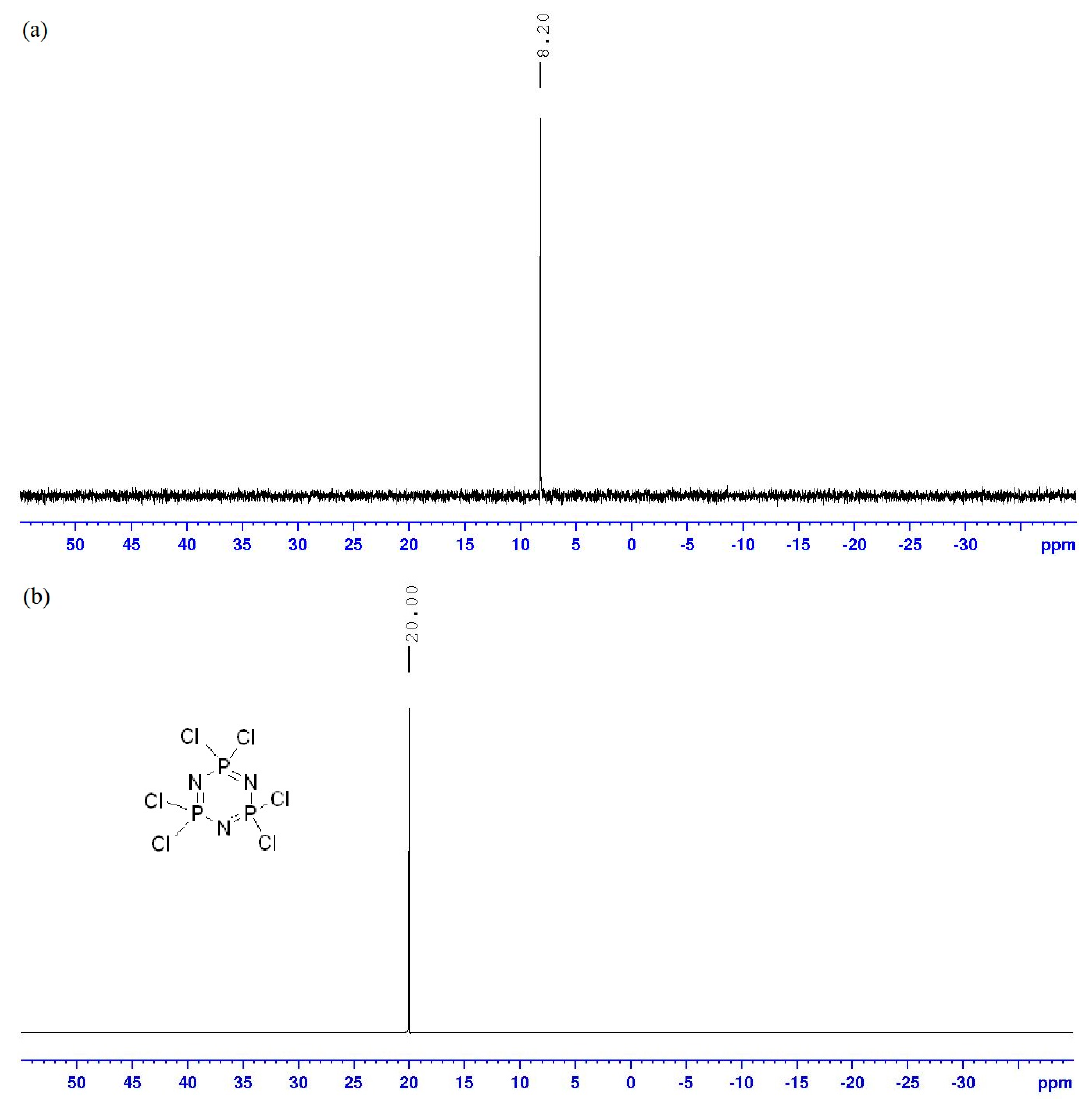
Figure 7. 31 P NMR spectrum of ( a ) compound 4a and ( b ) HCCP .